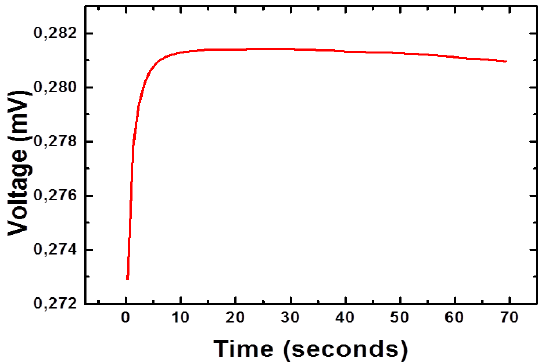
Figure 5. The response time of glucose biosensor in 1 mM glucose